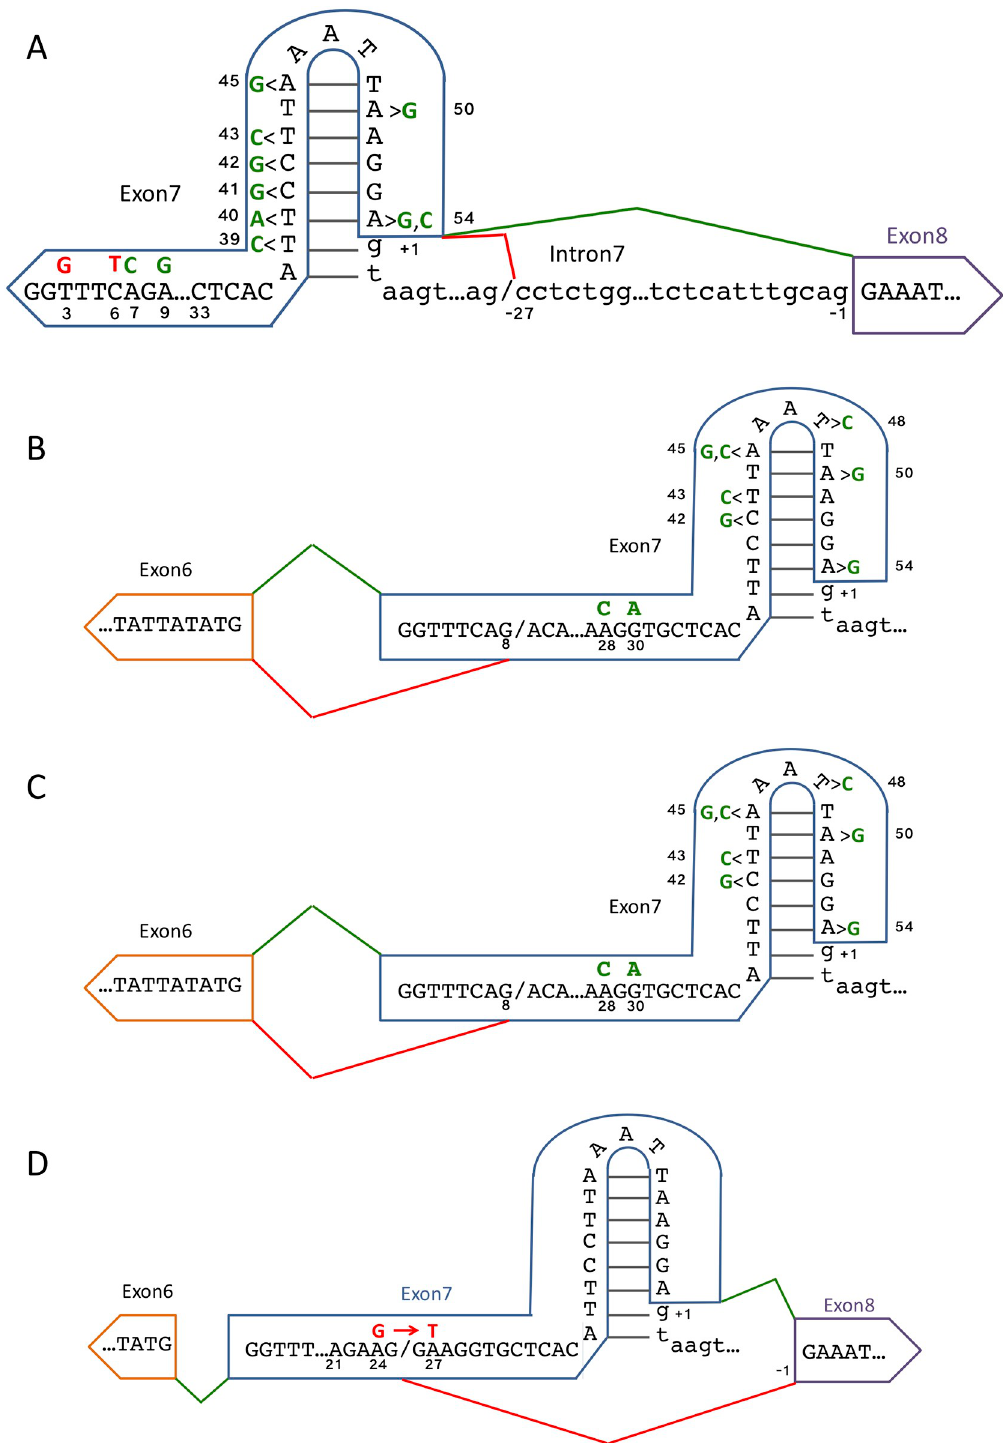
Fig 5. Mutant influence on non-canonical splice site usage. A) Mutant influence on non-canonical 3’SS usage between exon 7 and exon 8. The green line represents canonical SS usage, while the red line represents non-canonical 3’ SS usage 27 nucleotides upstream of the canonical intron7|exon8 junction. Mutations at positions in green influence more canonical SS usage, while mutations at position in red influence more non-canonical SS usage. B) Mutant influence on non-canonical 3’ SS usage between exon 6 and exon 7. The green line represents canonical SS usage, while the red line represents non-canonical 5’